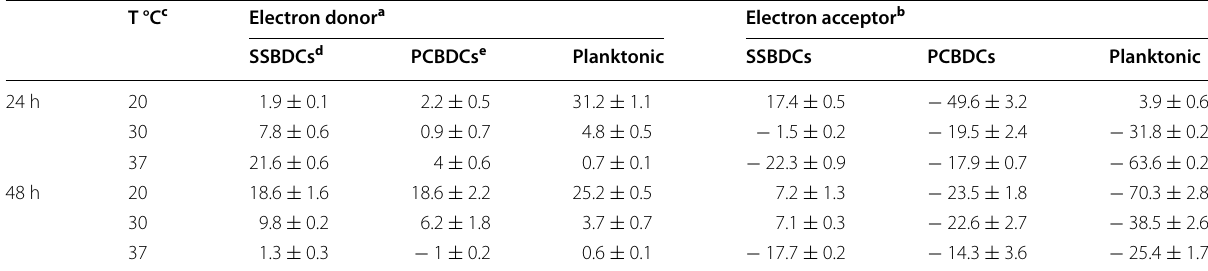
a The differences between the chloroform and hexadecane affinities of cells suspended in 100 mM PPB (pH 7) presents the electron donor character b The differences between the ethyl acetate and decane affinities of cells suspended in 100 mM PPB (pH 7) presents the electron acceptor character c T °C represents the growth temperature d SSBDCs represents the stainless steel-biofilm-detached-cells e PCBDCs represents the